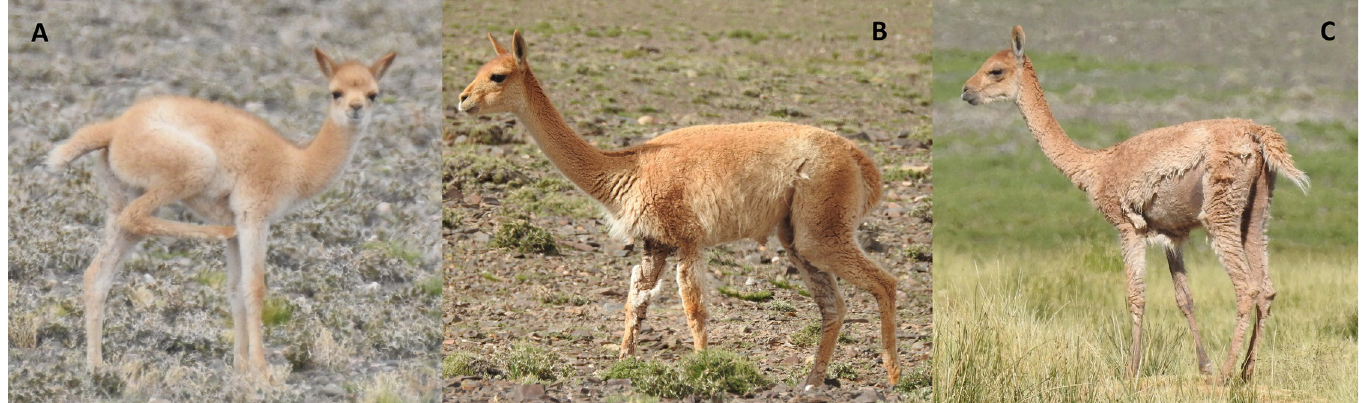
Fig 2. Clinical stages of mange in living vicu ñ as: (A) early stage, (B) advanced stage and (C) severe stage.